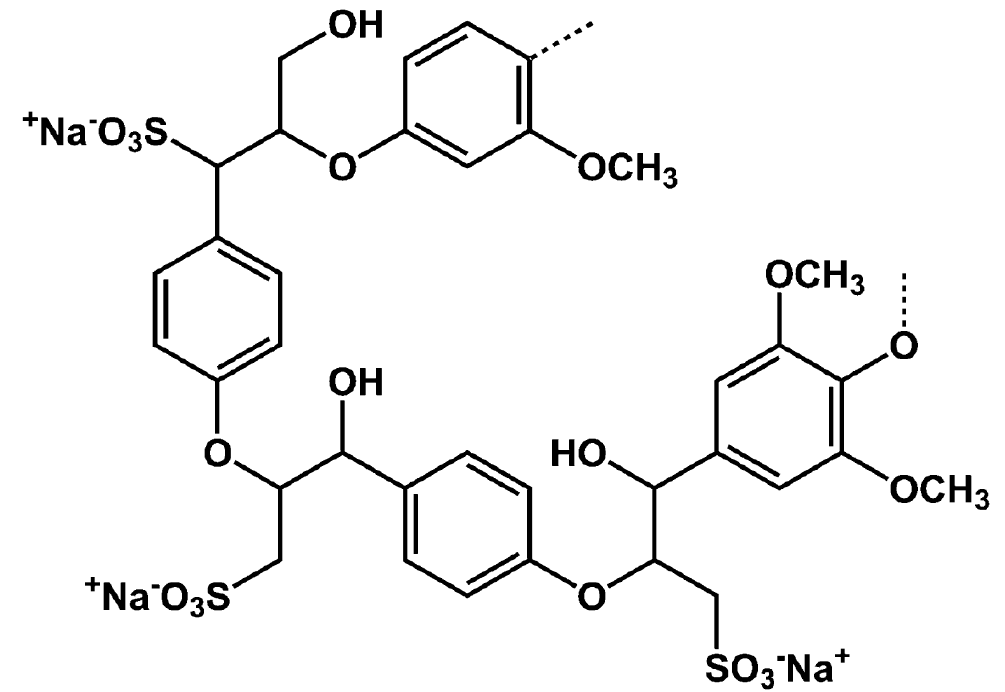
Figure 1. A proposed structure for lignosulfonate. Sulfonate groups are present in the aliphatic side chains. Adapted with permission from [9], Elsevier,